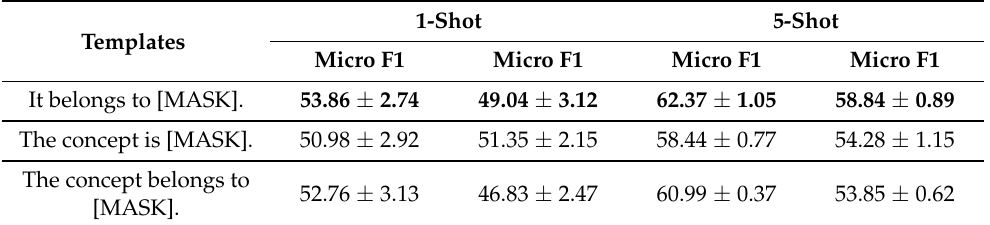
Table 5. Results of the different design of the templates. Metrics marked in bold contain the highest metrics for the dataset.